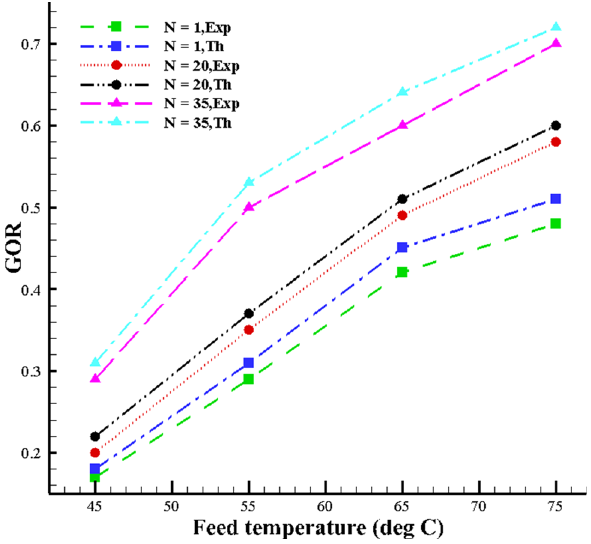
Fig. 8 Validation and comparison of GOR from experimental and theoretical